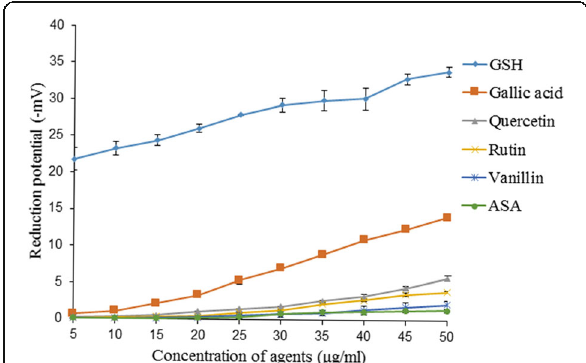
Fig. 1 Reduction potential; reduced glutathione, gallic acid, vanillin, acetylsalicylic acid, quercetin and rutin were added at 5 – 50 μ g/ml of phosphate buffer saline (pH 7.4). The reduction potential was measured in milivolt (mV) using ORP electrode. Reduced glutathione was used as a positive control. Values are represented as mean±SEM of three